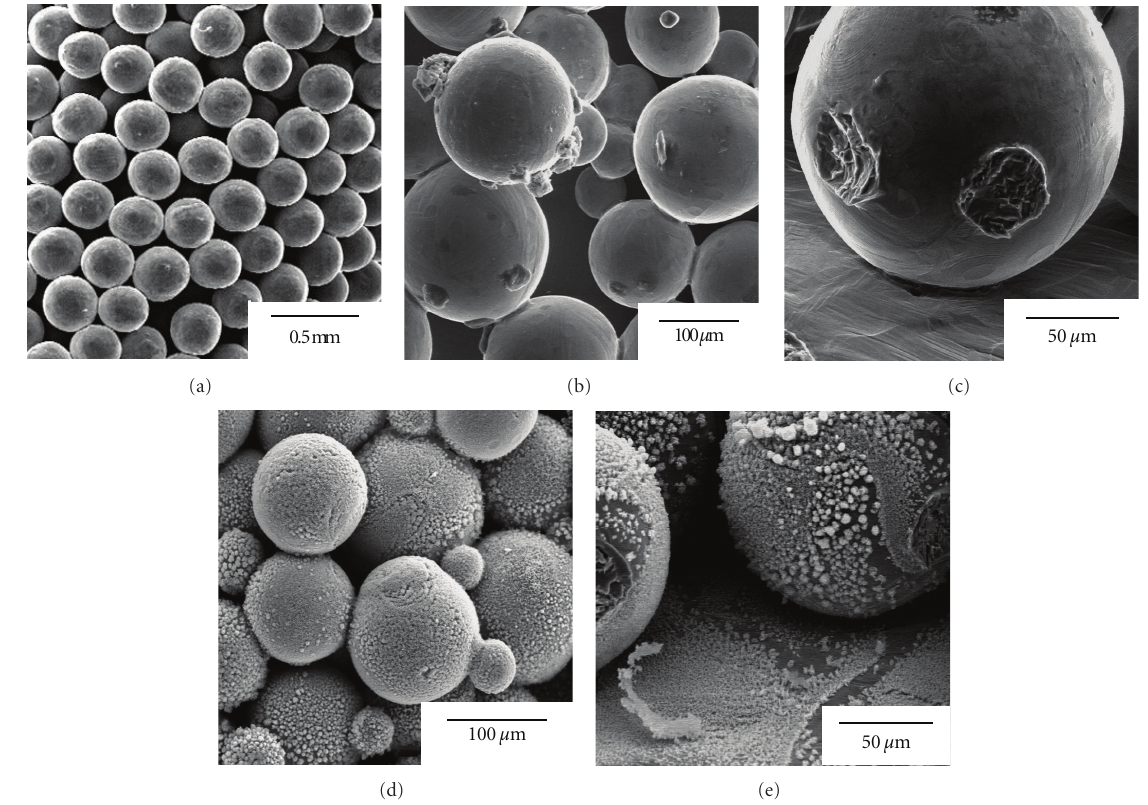
Figure 5: Surface and/or cross-sectional views of the samples with surface roughness. (a)–(c) bead-sintered porous samples (as sintered), (d)-(e) bead-sintered porous samples coated with HAp (thermal substrate method, 0.7 mM CaCl 2 + 0.3mM Ca(H 2 PO 4 ) 2 , pH 7, 100 ◦ C,